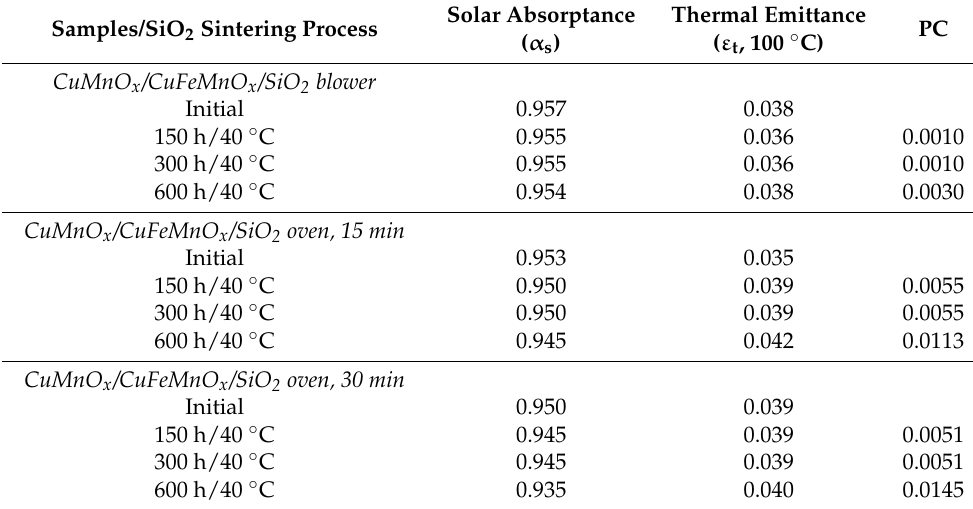
Table 5. Solar absorptance, thermal emittance and PC values calculated before and after each degradation interval for the samples during the condensation test at 40 ◦ C. All the values are the average of the values obtained for the six